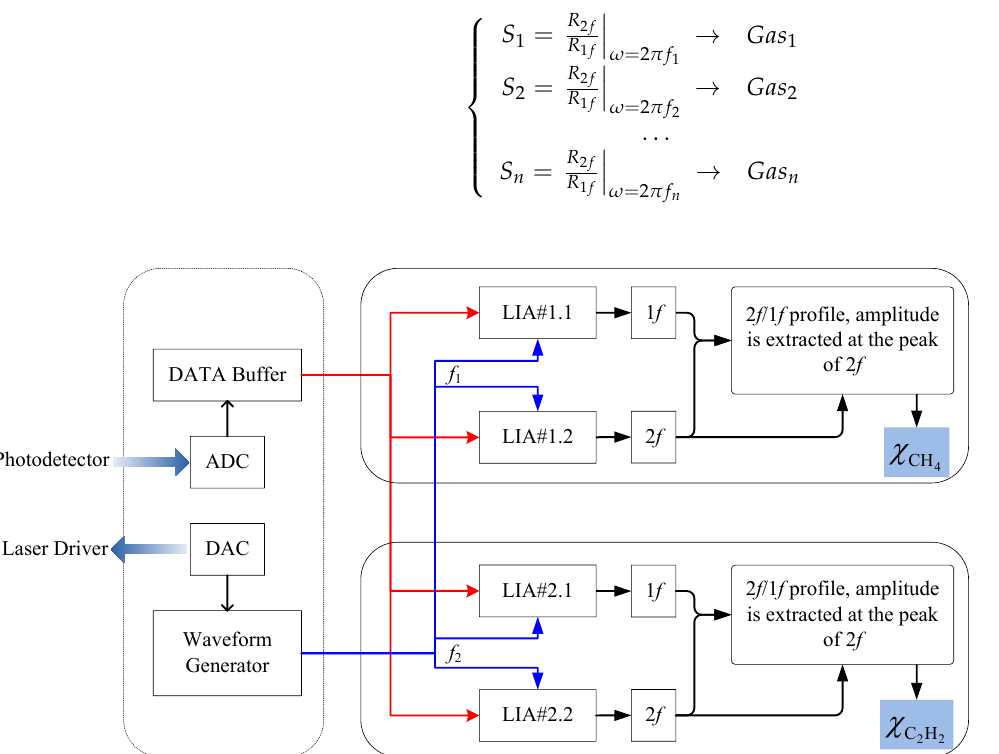
Figure 4. Flow chart of the LabVIEW-based data retrieval. Red lines represent the raw data stream and blue lines represent LIA reference provided by the on-board waveform generator. ADC, analog to digital converter; DAC, digital to analog